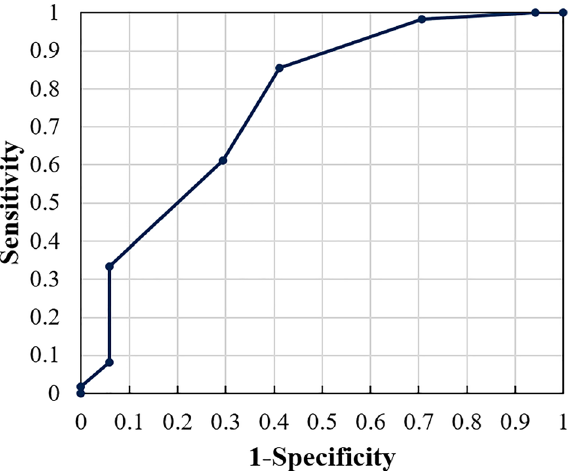
Figure 3. Receiver operating characteristic (ROC) curve indicating prediction performance of proposed model.